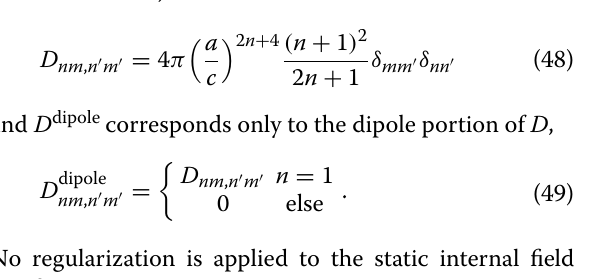
onal matrix with one block per satellite fluxgate instru- ment. Each satellite block has the form